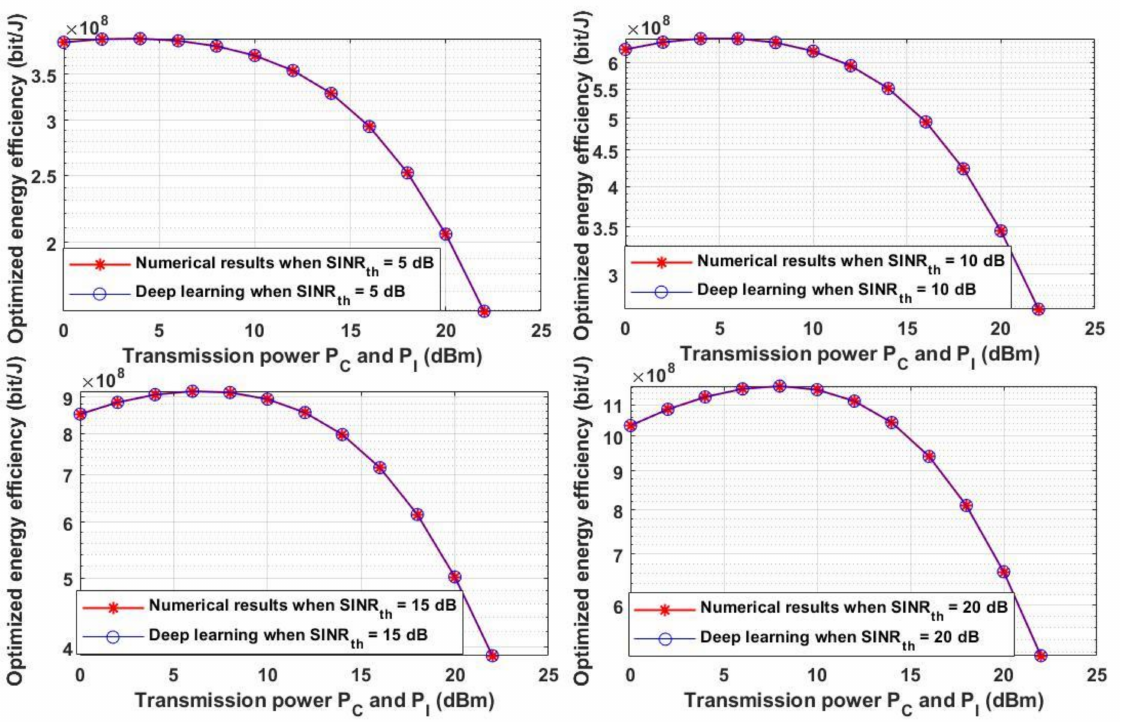
Figure 12. Transmission power P C and P I versus optimized energy